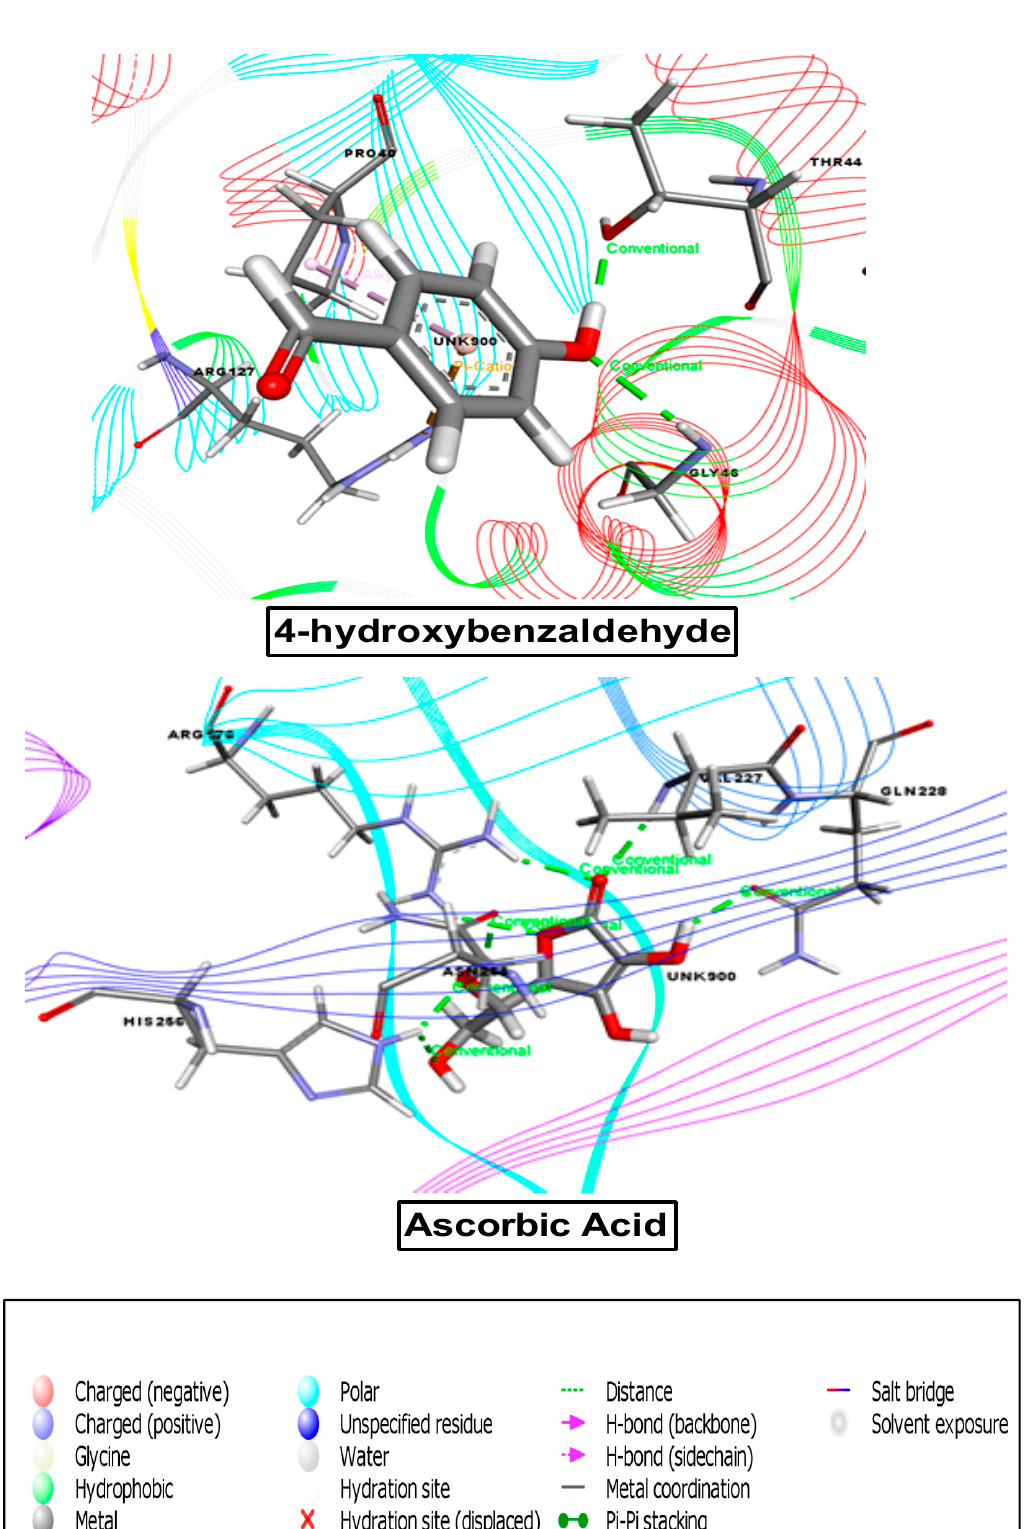
Figure 5. Best ranked pose of the best compound of M. capitulata . 4-hydroxybenzaldehyde and standard drug (ascorbic acid) in the binding pocket of human peroxiredoxin 5 (PDB ID: 1HD2) for antioxidant activity.